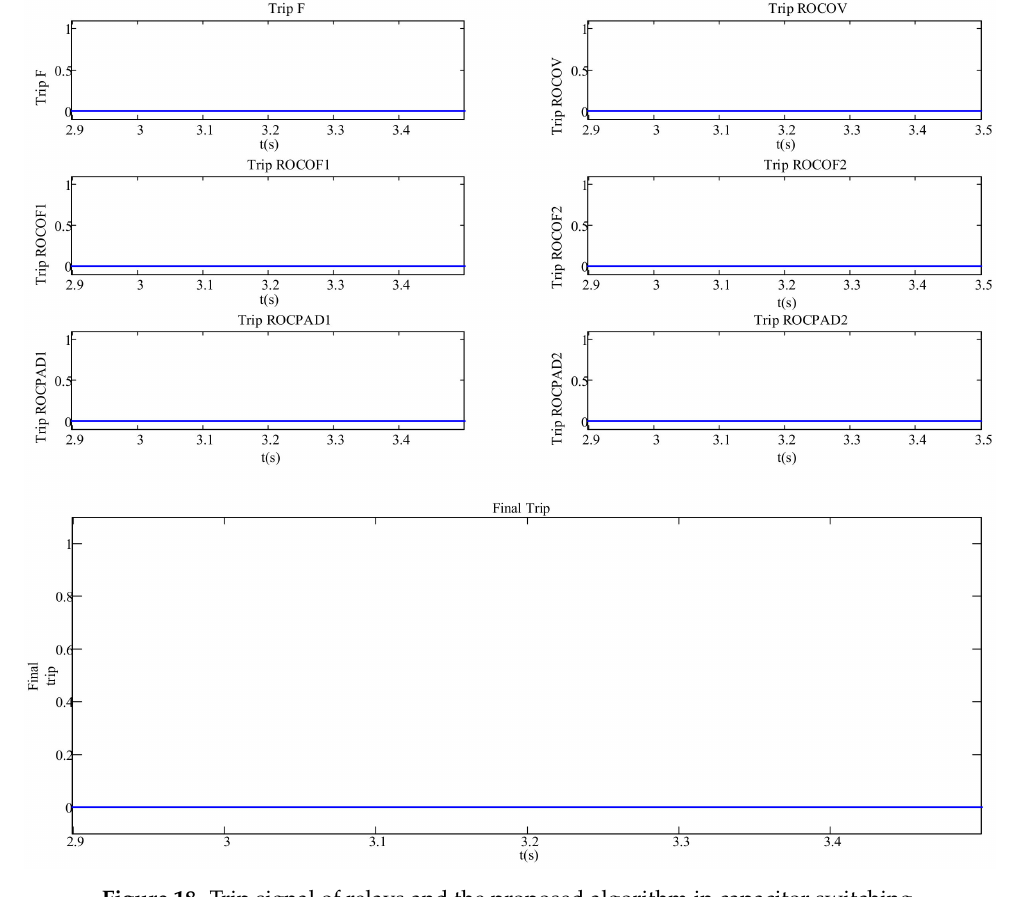
Figure 18. Trip signal of relays and the proposed algorithm in capacitor